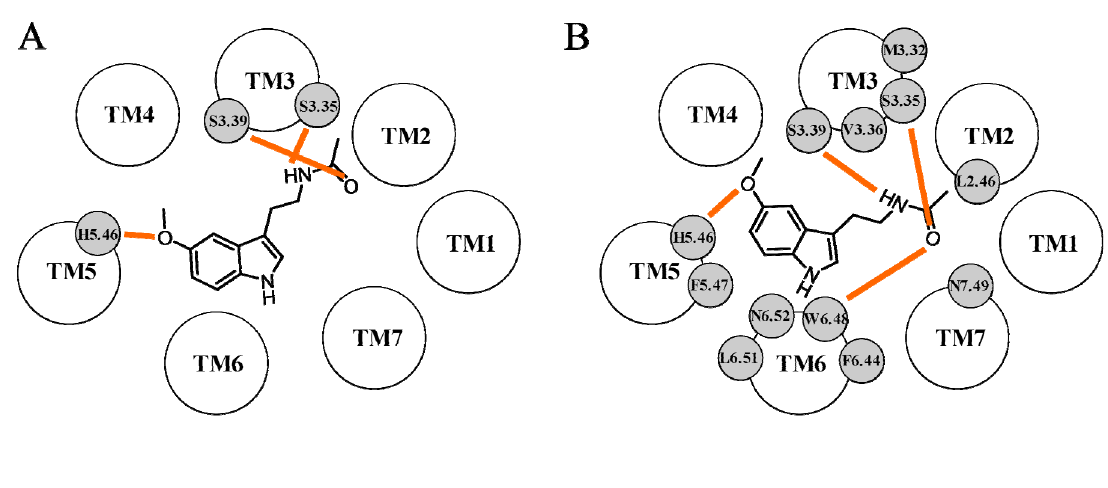
binding site. Hydrogen bond interactions are 1